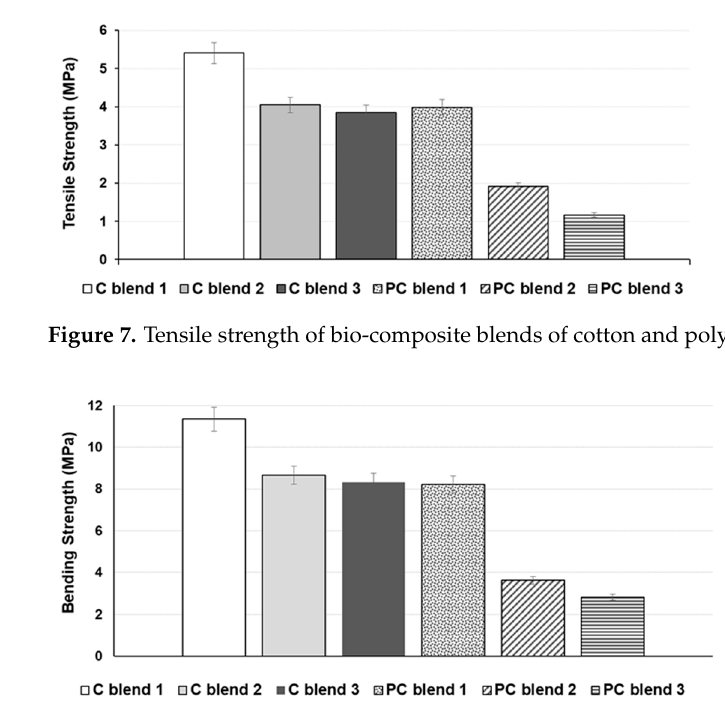
Figure 10. Bending strength of treated and untreated cotton and polycotton blends. 3.3. Tensile Strength and Compressive Strength of Seedling Pots The formulated seedling pots attained higher tensile and compressive strengths as compared to the commercial pots (Figures 11 and 12). Specifically, the cotton blend pot achieved the optimum tensile and compressive strengths of 4.81 MPa and 256.64 N, re- spectively. The higher cellulose content of the cotton blend pot and the use of cornstarch